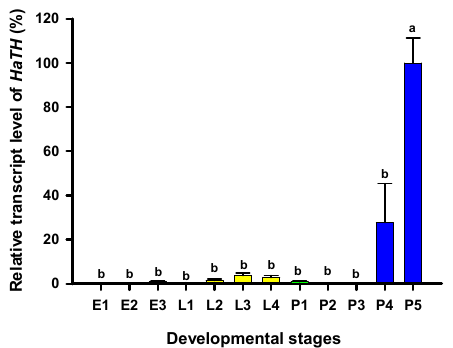
Figure 1. Relative transcript levels of HaTH at different developmental stages of Harmonia axyridis as determined by RT-qPCR. E1, E2, and E3 represent 1-, 2-, and 3-day eggs, respectively; L1, L2, L3, and L4 represent first, second, third, and fourth instar larvae, respectively; P1, P2, P 3, P4, and P5 represent 1-, 2-, 3-, 4-, and 5-day pupae, respectively. Different letters above the standard error bars indicate significant differences based on SPSS (v. 22, IBM Corp. Armonk, NY, USA) followed by One-Way ANOVA ( p < 0.05). H. axyridis ribosomal protein 49 ( HaRp49 ) was used as an internal reference gene to normalize the differences among the samples. Relative expression levels for HaTH were calculated based on the highest expressions of HaTH in 5-day pupae (P5) as 100% in the developmental stage.